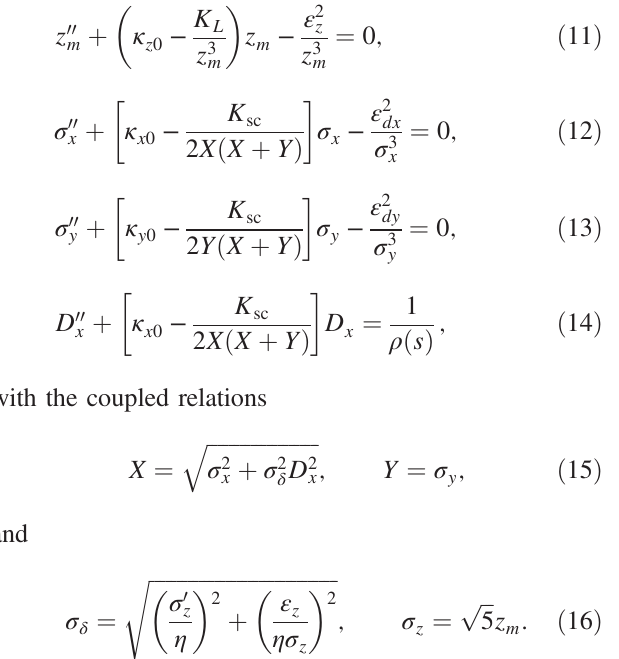
ffiffiffi p 5 z : ð 16 m